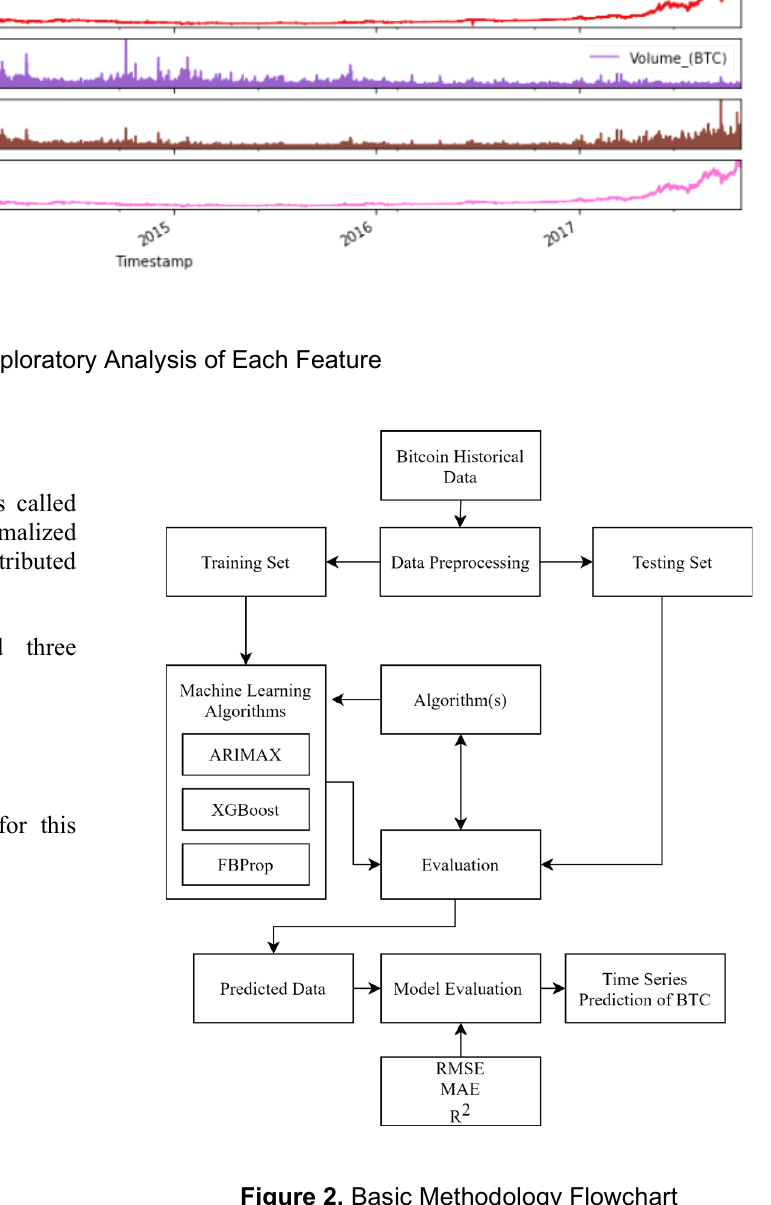
Figure 2. Basic Methodology